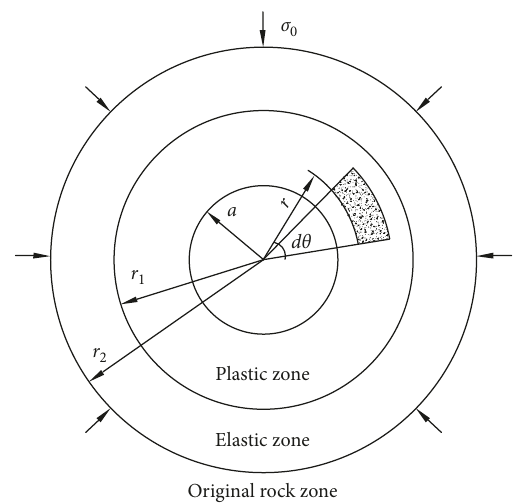
Figure 3: Elastic and plastic zone distribution of the surrounding